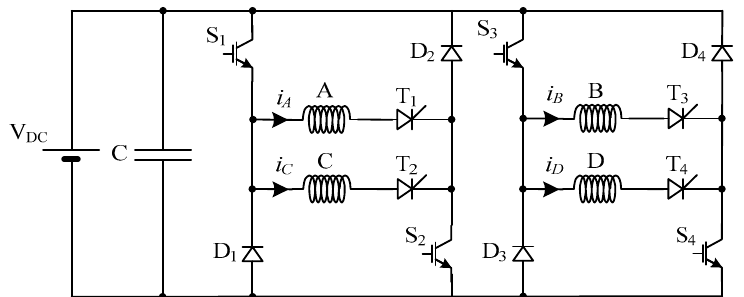
Figure 3. Shared phase winding topology.